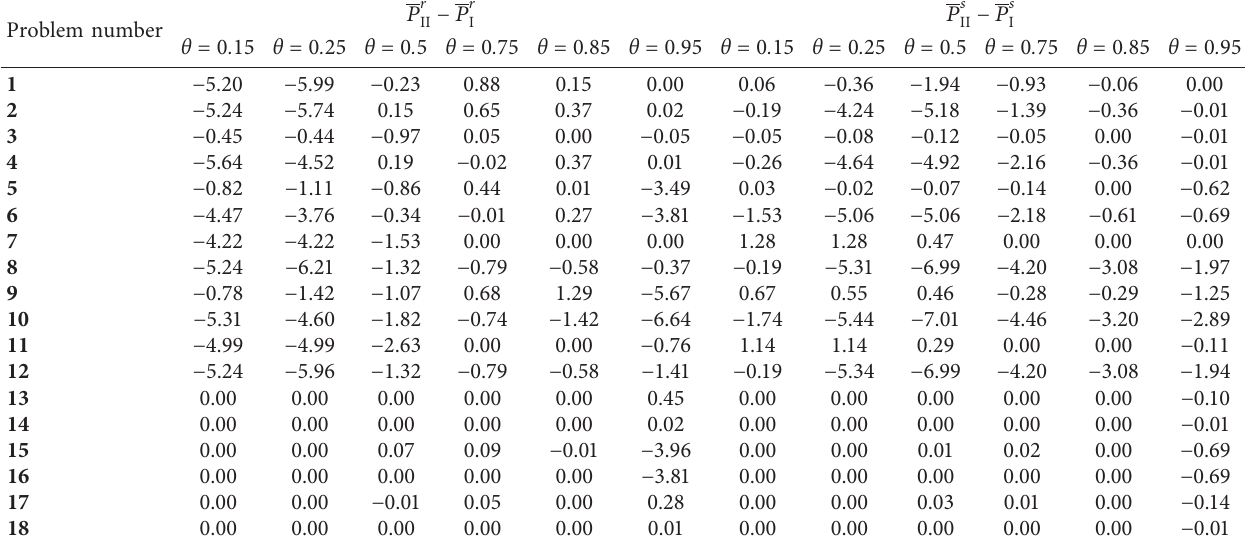
Table 5: Comparison of obtained profits under both decentralized and centralized supply chain.